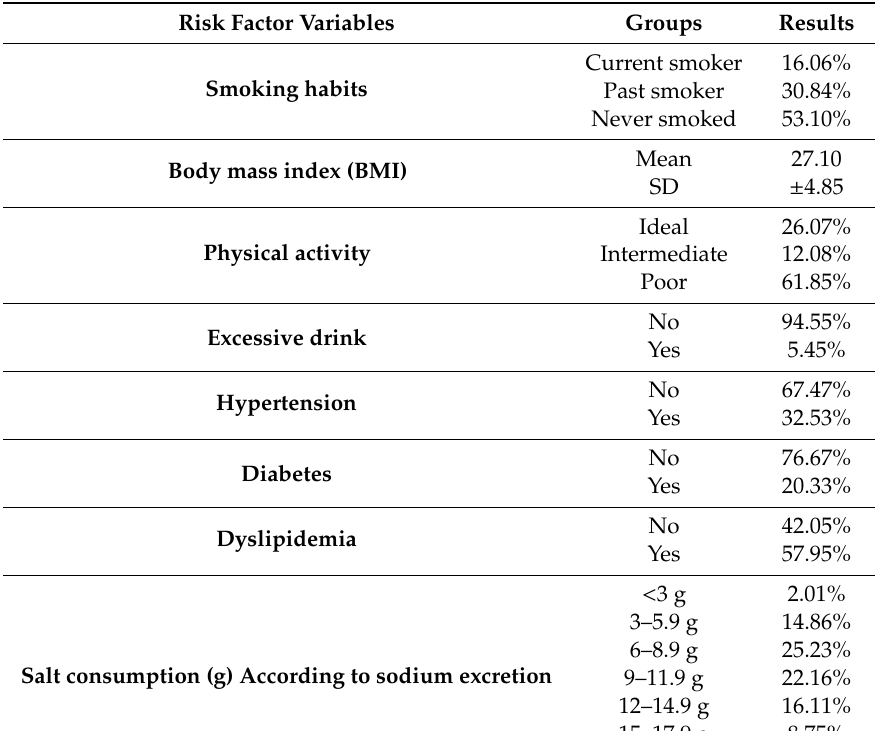
Table 2. The risk factors for cardiovascular diseases considered in ELSA-BRASIL ( n =